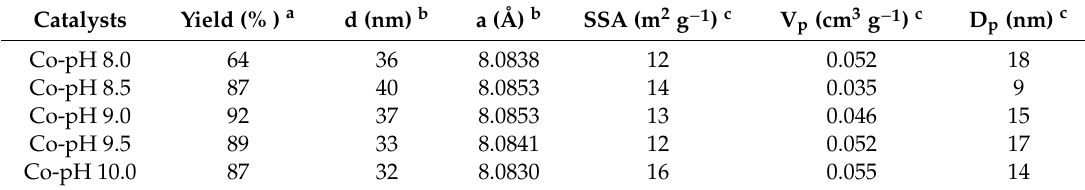
Figure 2. Fourier transform-infrared spectroscopy ( FTIR) spectra of ( A ) cobalt precursors and ( B ) cobalt oxides prepared at different pH values.